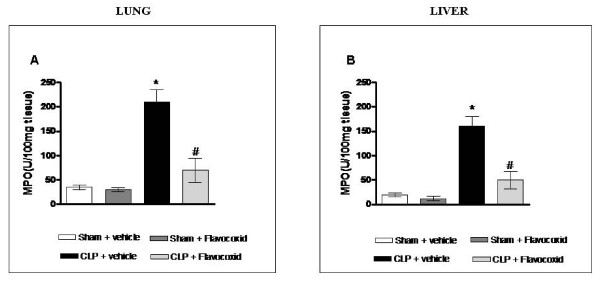
Myeloperoxidase (MPO) activity in the lung (a) and liver (b) obtained from CLP and sham mice. Animals were treated with flavocoxid (20 mg/kg, ip) or vehicle (NaCl 0.9%) 1 hour after surgery, repeated every 12 hours. Bars represent the mean ± SD of six animals. *P < 0.005 compared with sham + vehicle or flavocoxid; #P < 0.005 compared with CLP + vehicle.